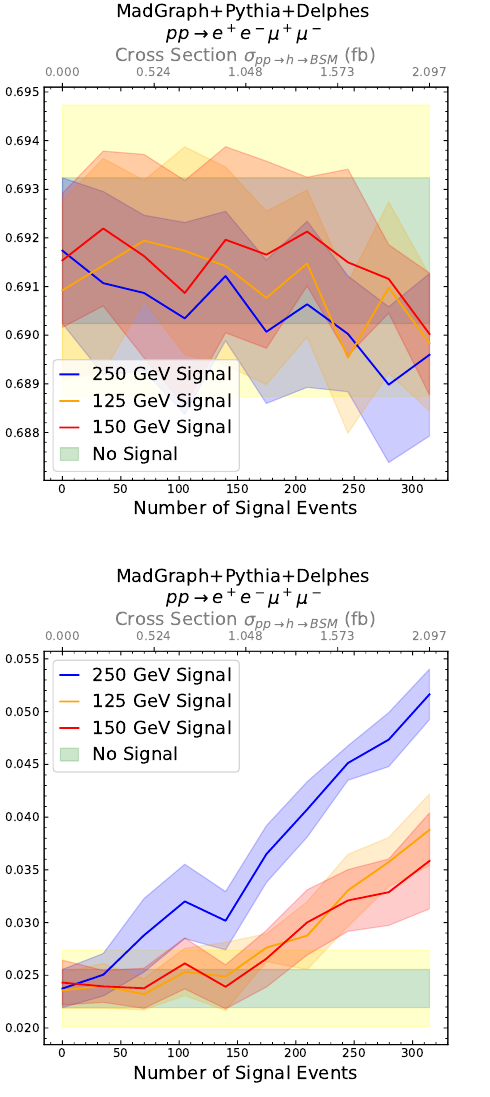
Figure 5 . BCE Loss. Same as figure 4, but zoomed in by a factor of 10 on the horizontal axis. The 95% exclusion limits approximately correspond to where the lines for each signal cross the yellow 2 σ band for the background-only